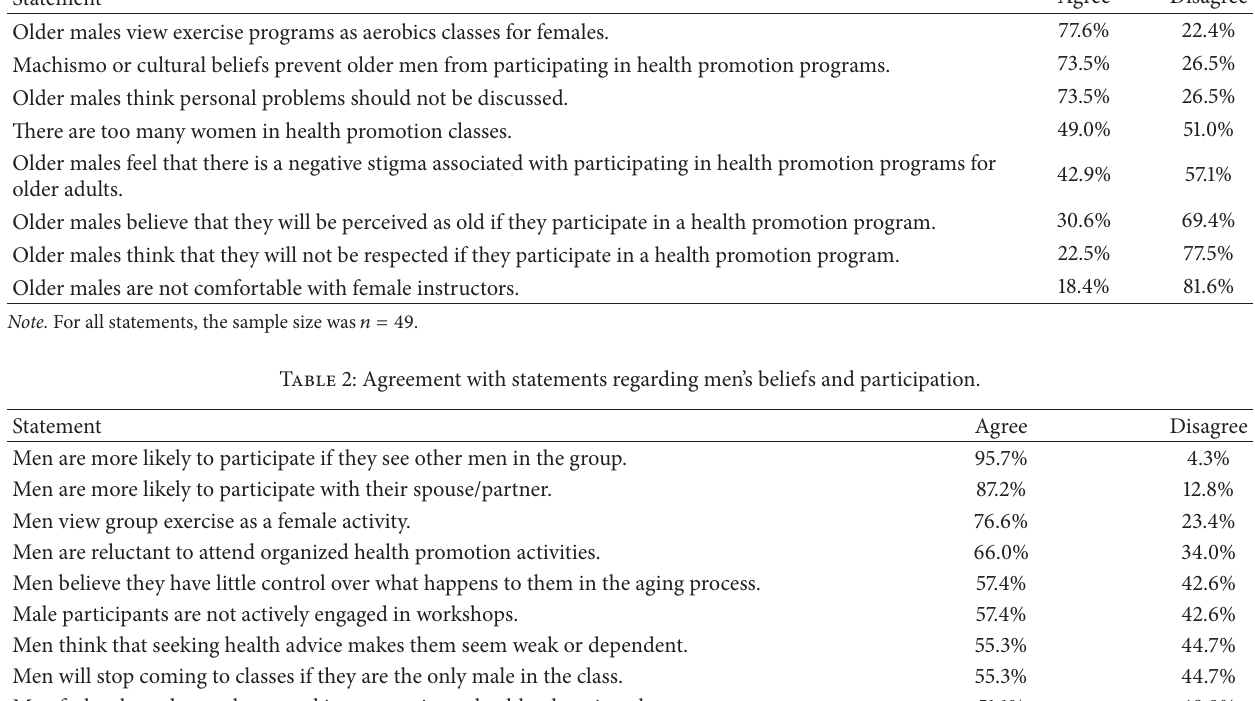
Table 1: Agreement with statements explaining why older males do not participate in HARC programs. Statement Agree